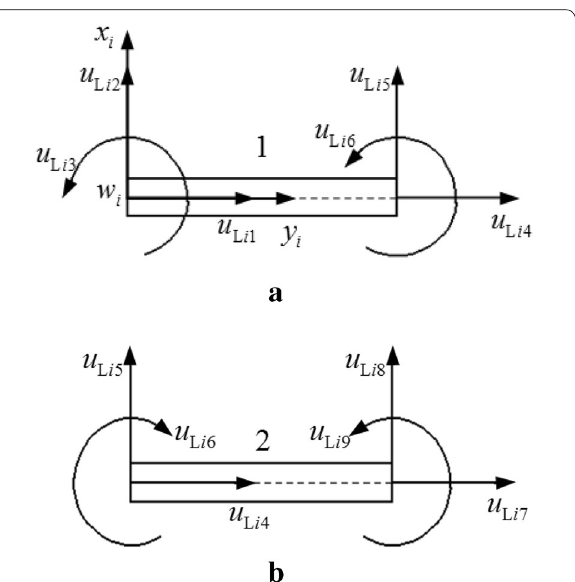
Figure 5 Finite element model of linear motor: a first unit; b second